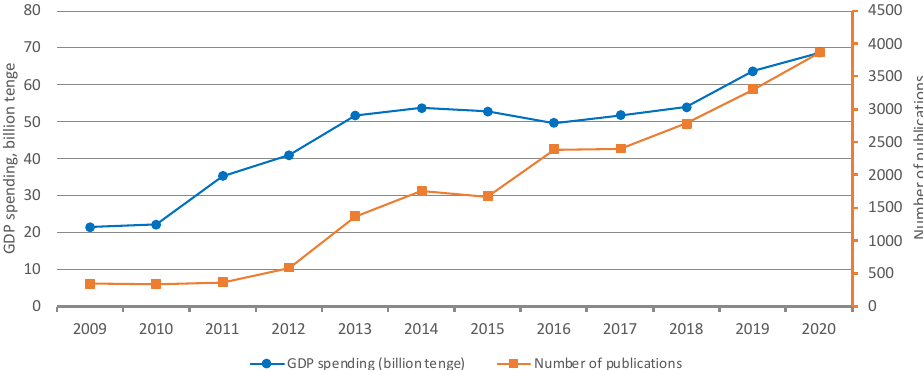
Figure 1. The trend in the GDP spending and published papers for 2009–2020.